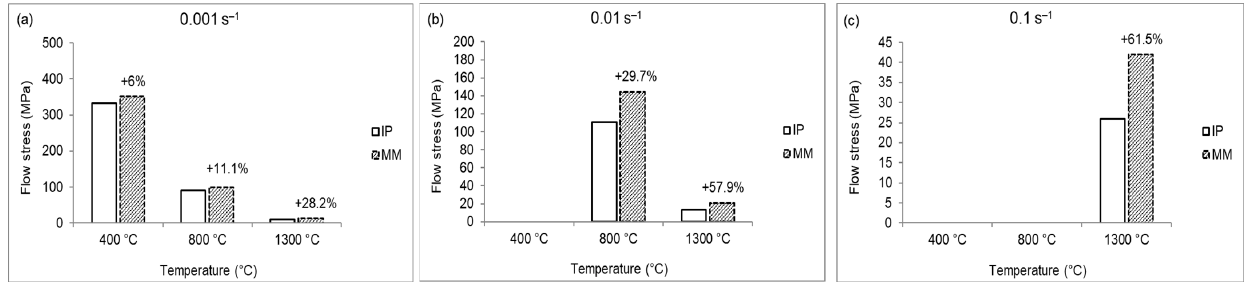
Figure 4. Maximum flow stress σ p of IP and MM at the three different strain rates. ( a ) 0.001 s − 1 ; ( b ) 0.01 s − 1 ; ( c ) 0.1 s − 1 .